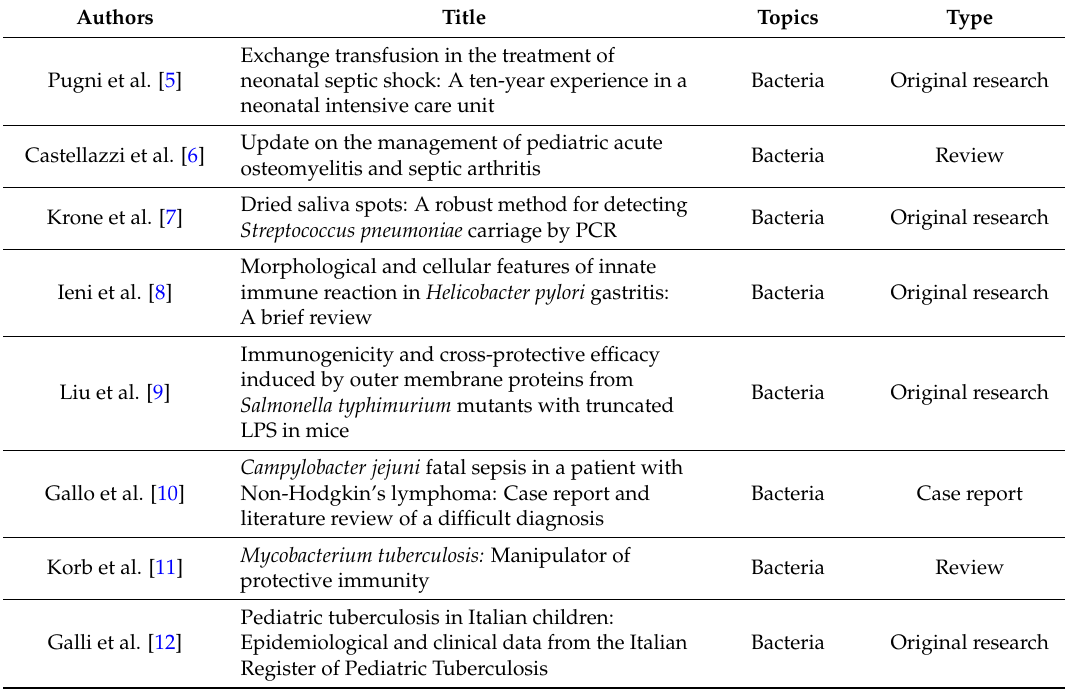
Table 1. Summary of papers in the Special Issue “Infectious diseases: pathophysiology, diagnostics and prevention”, arranged by